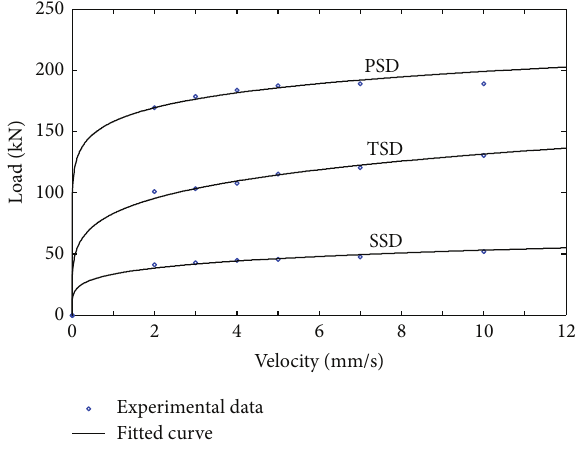
Figure 5: Load-velocity relationship of MSDs. Table 3: Five cases for numerical